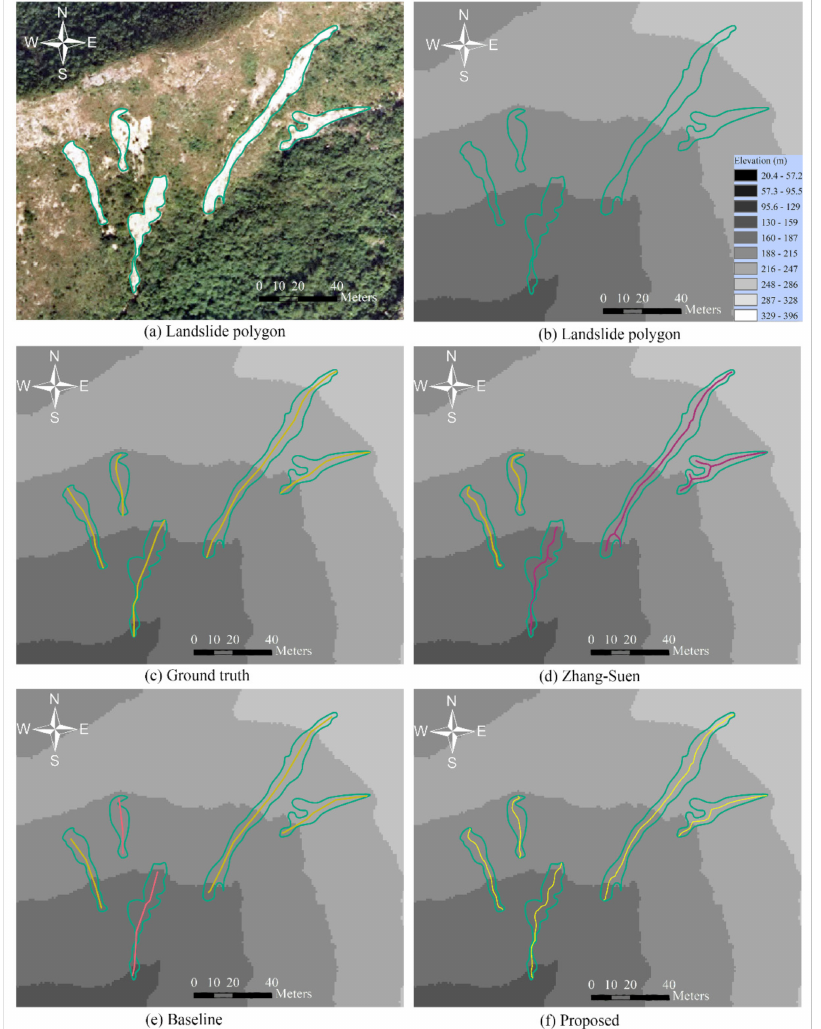
Figure 13. Close ups of red boxes marked in Figure 12. ( a ) Landslide polygon overlaid on aerial photo; ( b ) landslide polygon; ( c ) landslide trails ground truth; landslide trail result obtained by ( d ) Zhang-Suen’s method, ( e ) the baseline method, and ( f ) the proposed method. Landslide features in ( b – e ) are overlaid on